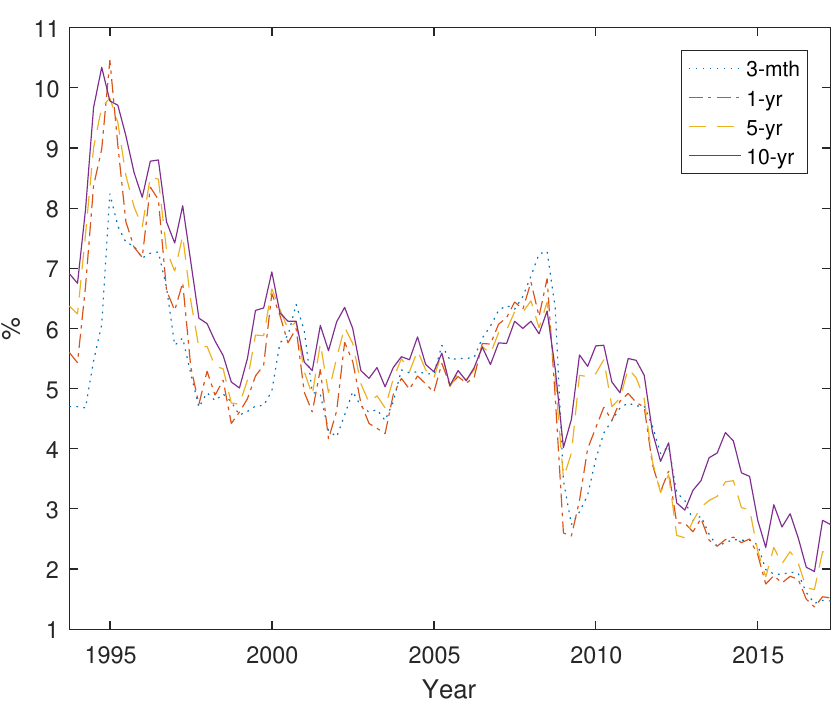
Figure A6. Short Term Yield